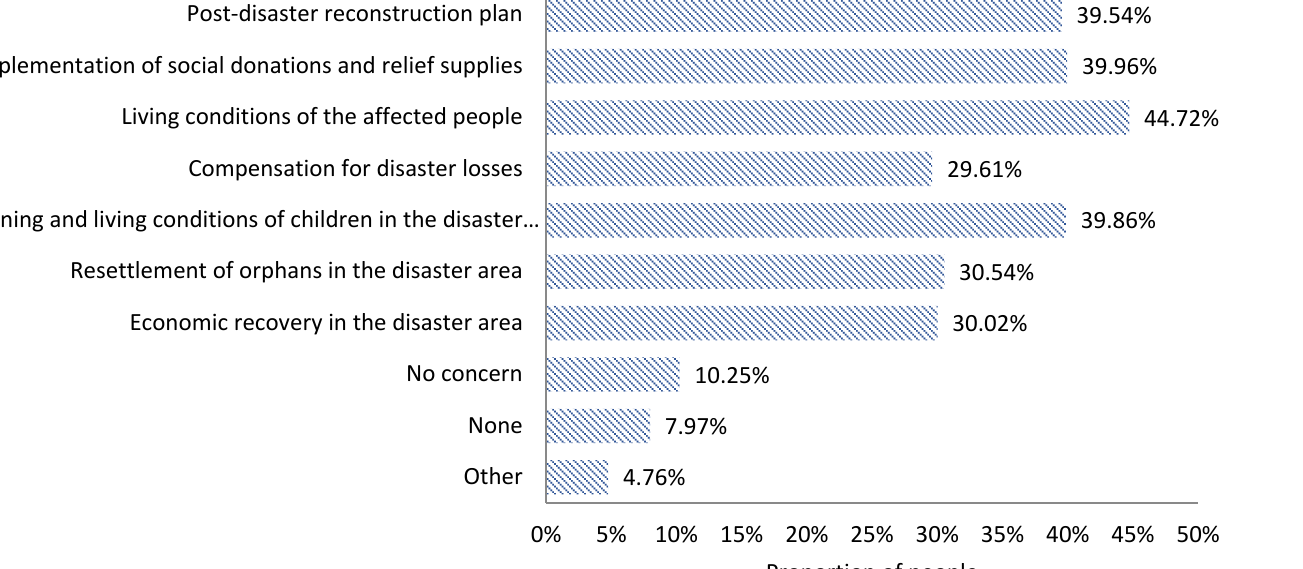
Figure 9. Information actually acquired by the public in the resolution stage of an earthquake disaster.